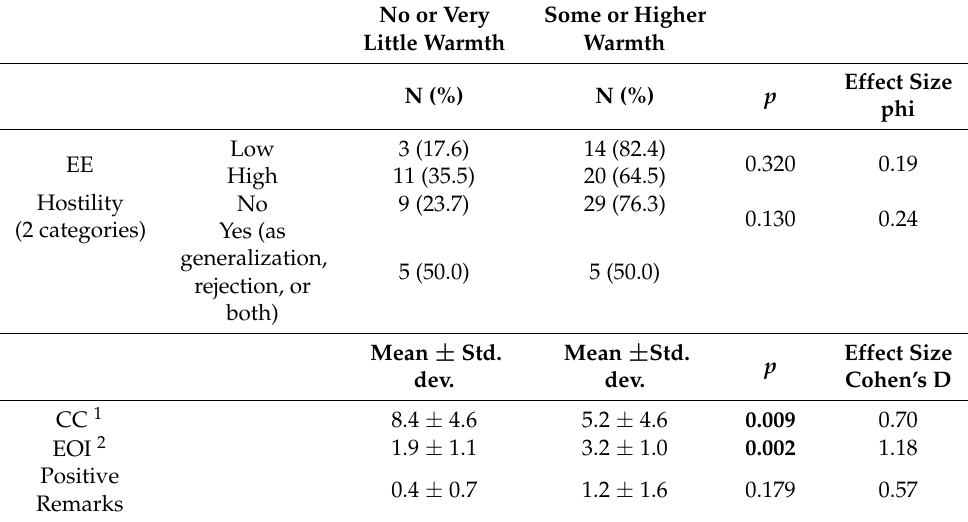
Table 4. Expressed emotion (EE) based on the level of relatives’